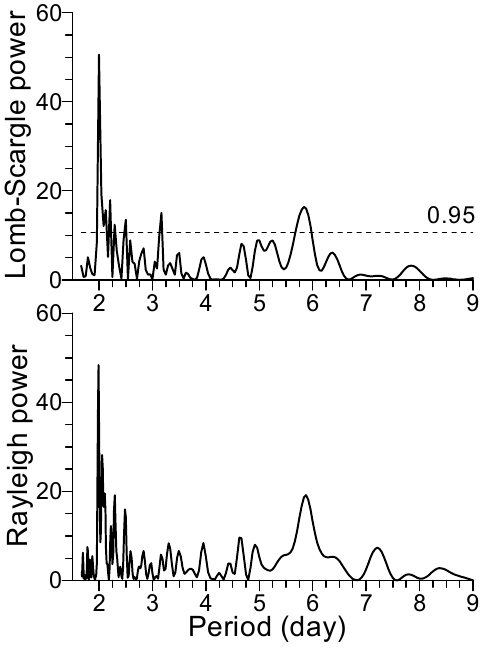
Fig. 2. Normalized power spectrum obtained by Lomb-Scargle method (top) and Rayleigh power (bottom) obtained for the UK meridional wind data in the time interval from 17 May to 17 September